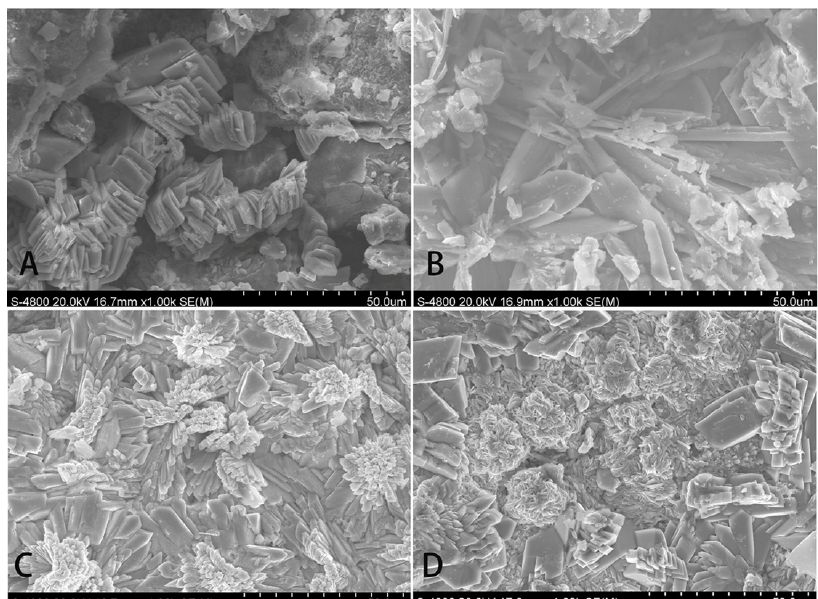
Figure 2. Surface micro topography by SEM analysis: ( A ) Brushite group; ( B ) 5% Sr group; ( C ) 10% Sr group; ( D ) 20% Sr group.